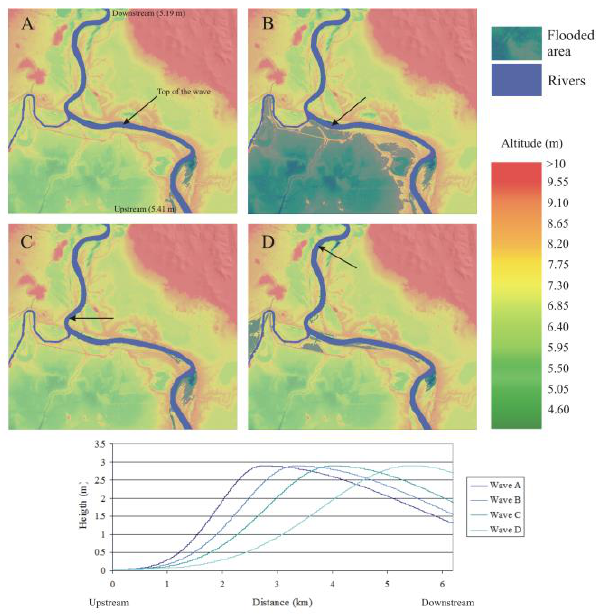
Figure 2. Wave flood calculation in the study